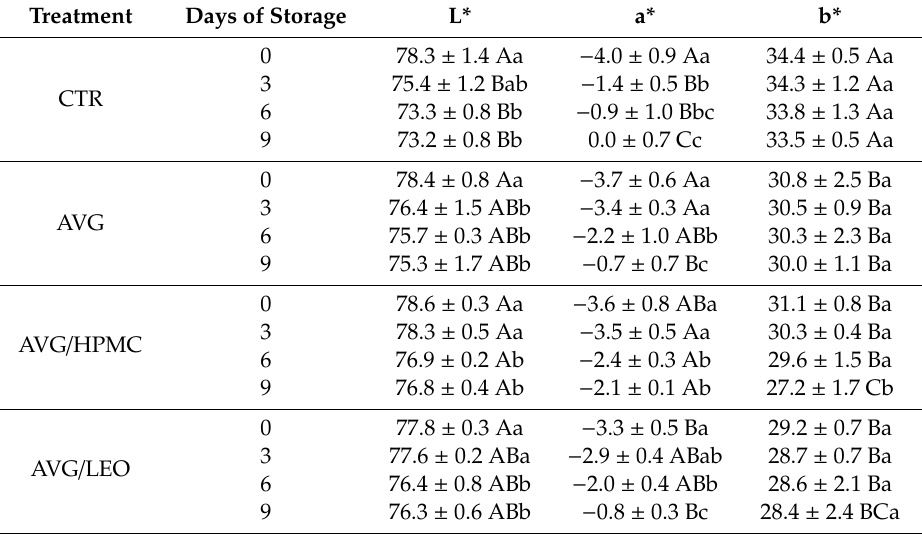
Table 1. Color characteristics of fresh-cut apples at 0, 3, 6, and 9 days of storage at 4 ◦ ± 1 ◦ C and 90% ± 5% RH (relative humidity) after all